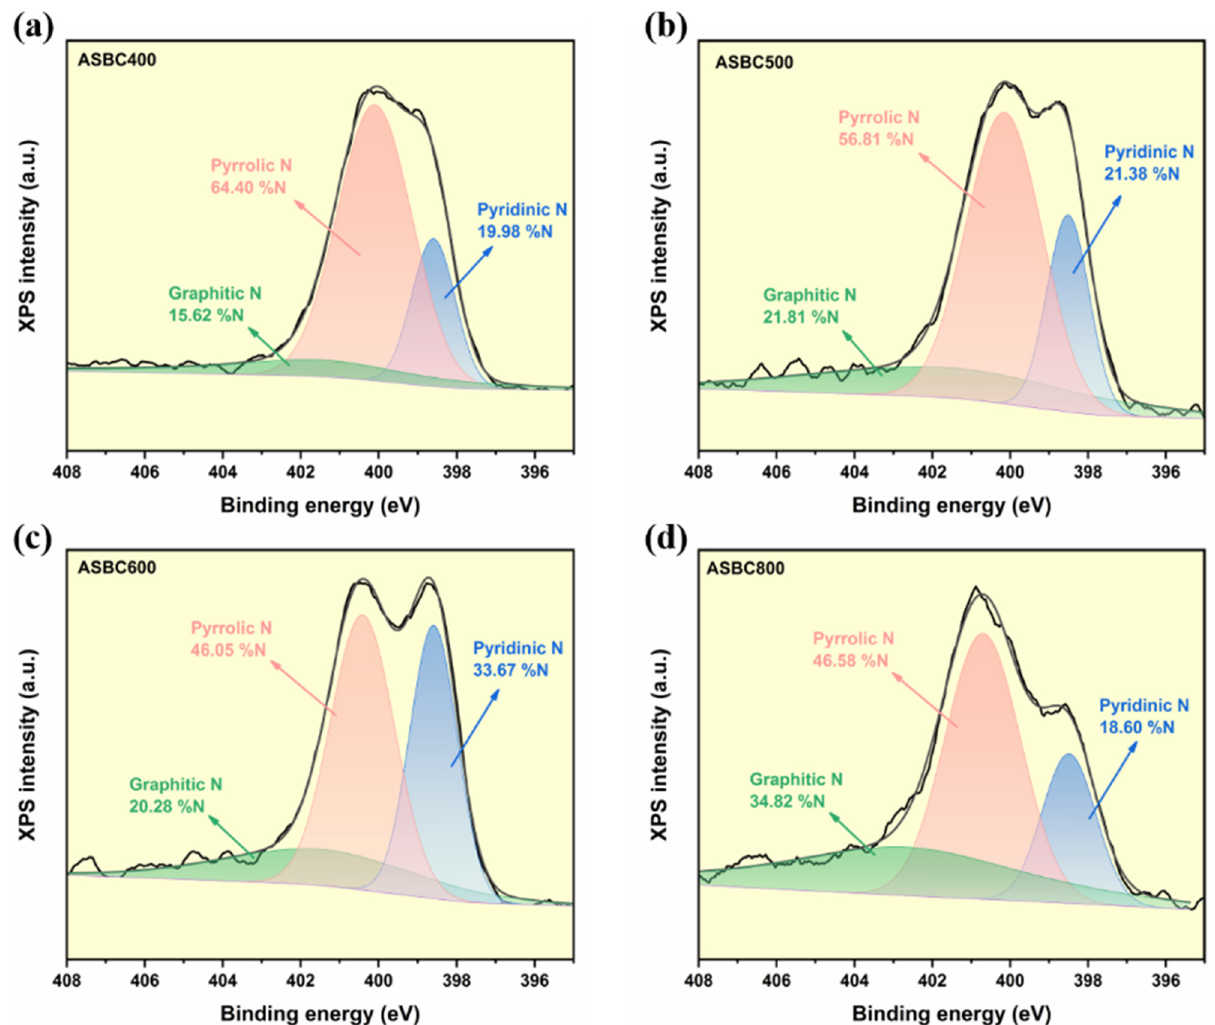
Figure 4. N 1s high-resolution spectrum of ASBC400 ( a ), ASBC500 ( b ), ASBC600 ( c ), and ASBC800 ( d ).